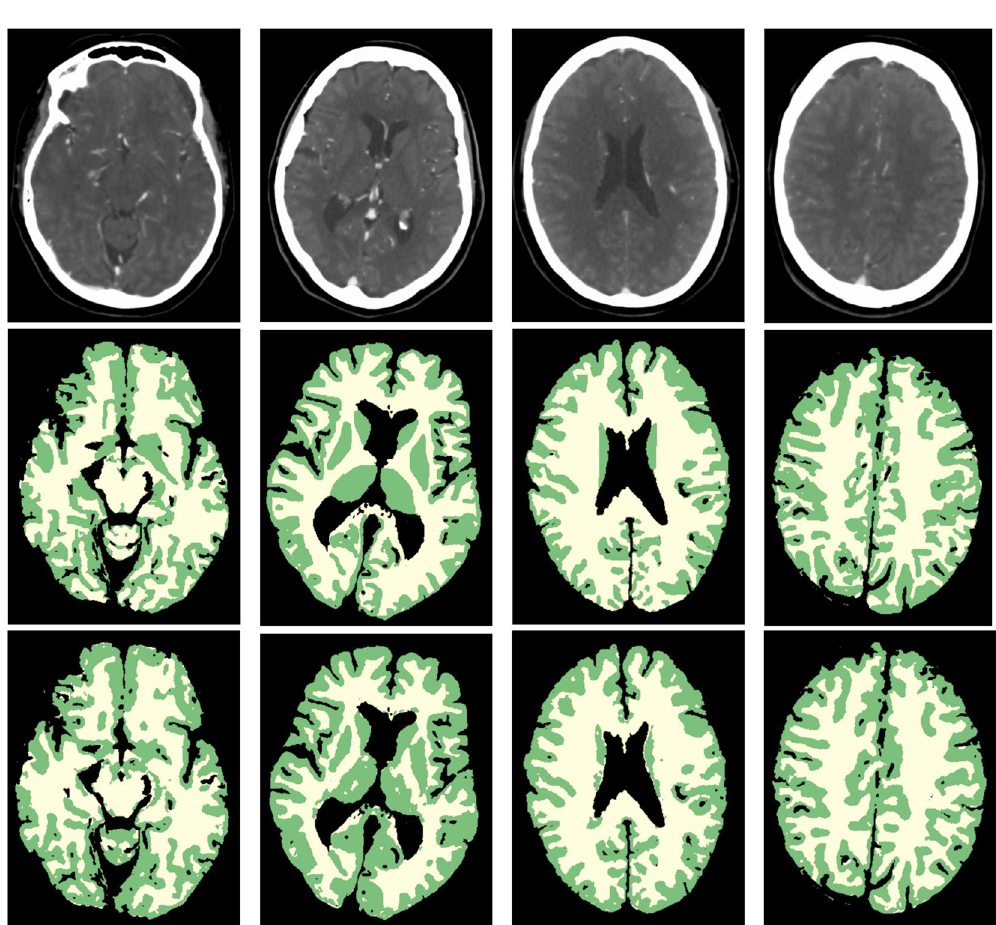
Figure 2. WM and GM segmentations of four different patients. From left to right: axial slices at approximately the level of the Circle of Willis, basal ganglia, lateral ventricles and centrum semiovale. From top to bottom: weighted temporal average (window width/level 300/100 HU); the reference standard; the final WM (yellow) and GM (green) segmentation with the proposed